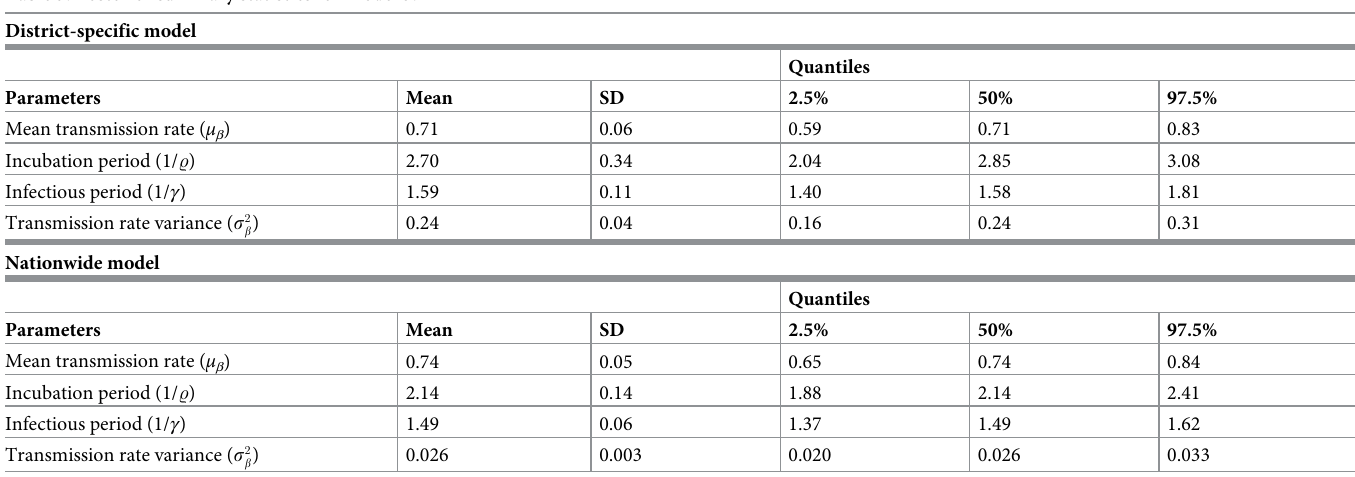
Table 3. Posterior summary statistics for Model